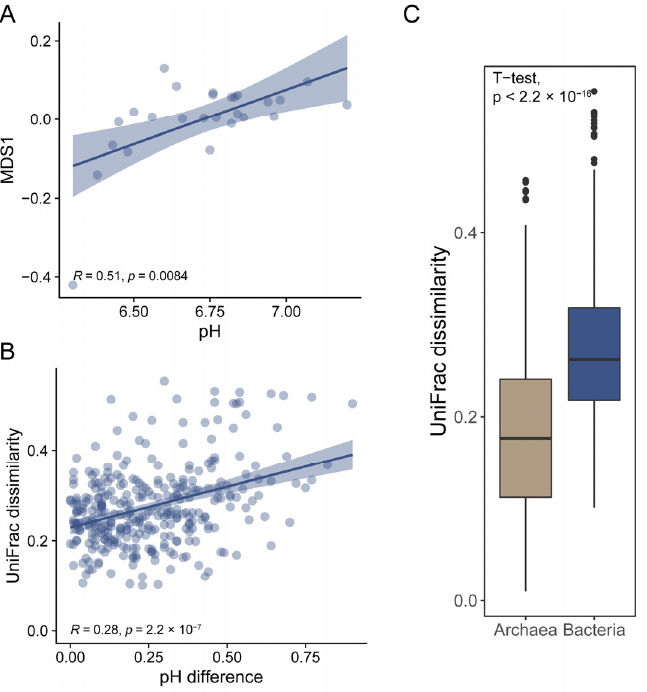
Figure 5. pH drives the bacterial composition in oil reservoirs at a localized geographic scale. ( A ) the relationship between the microbial profiles and pH values. Points represent the MDS1 values of each sample; line represents the fit line between pH and MDS1 values. ( B ) the relationship between beta diversity and pH difference. Points represent the UniFrac dissimilarities between each sample; line represents the fit line between pH and the UniFrac dissimilarities. ( C ) comparison of archaeal and bacterial beta diversity within the produced water samples.